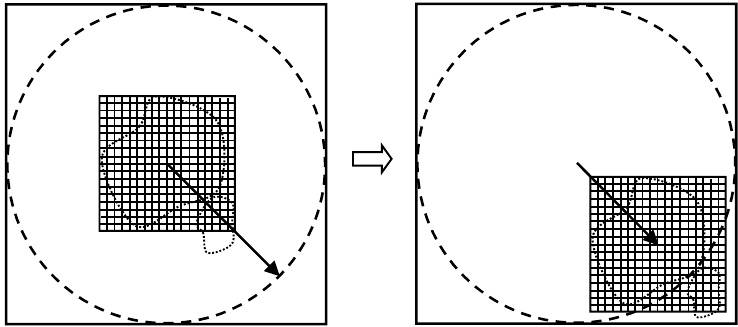
Figure 1. A schematic diagram illustrating TREC